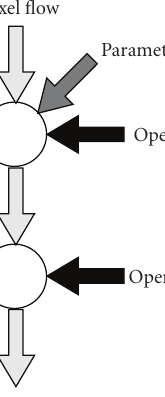
Figure 3: Unary identical preprocessing units.